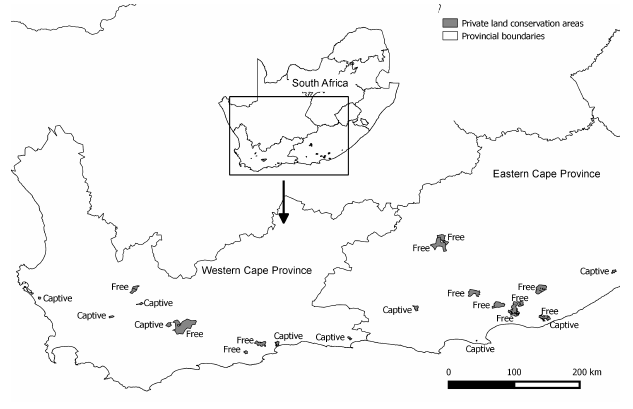
Fig. 2 . Map of the Western and Eastern Cape Provinces of South Africa displaying the 22 surveyed private land conservation areas that stocked large predators, with 12 supporting free-roaming (“free”) large predators, and 10 supporting captive large